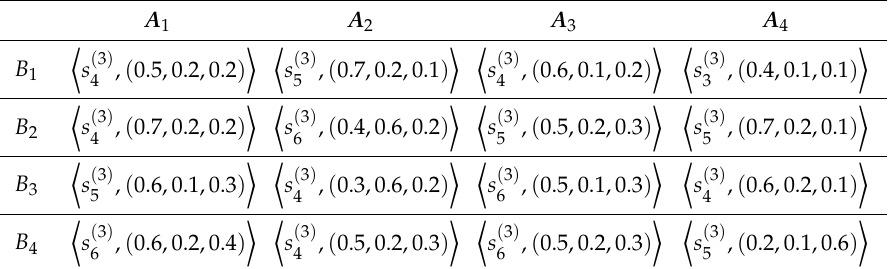
Table 3. SVNL decision matrix R 2